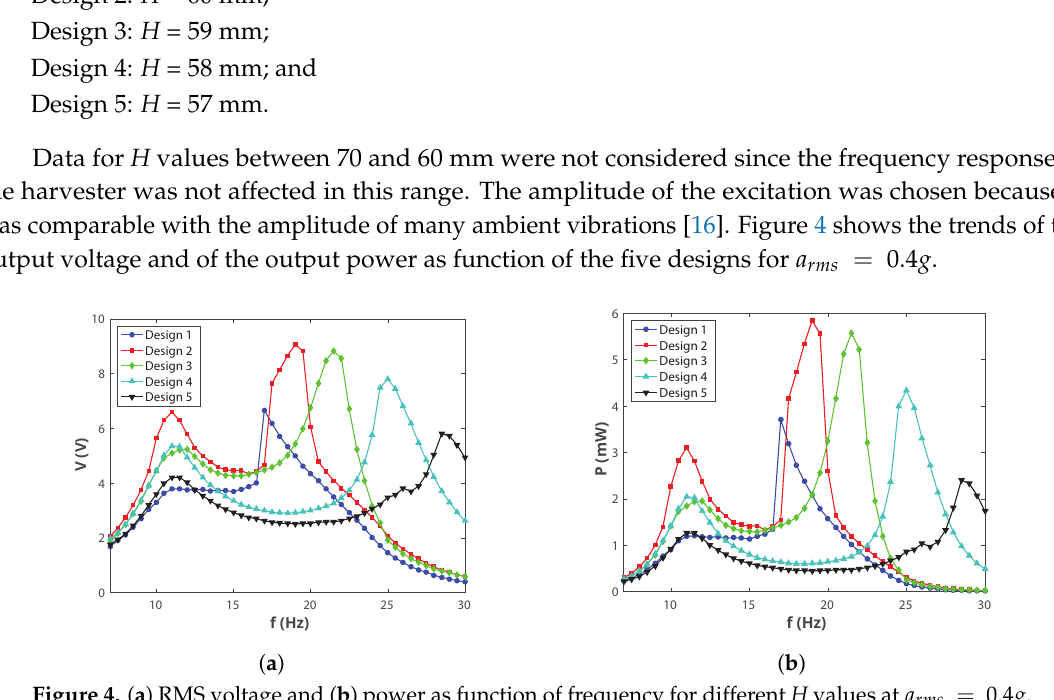
Figure 4. ( a ) RMS voltage and ( b ) power as function of frequency for different H values at a rms = 0.4 g